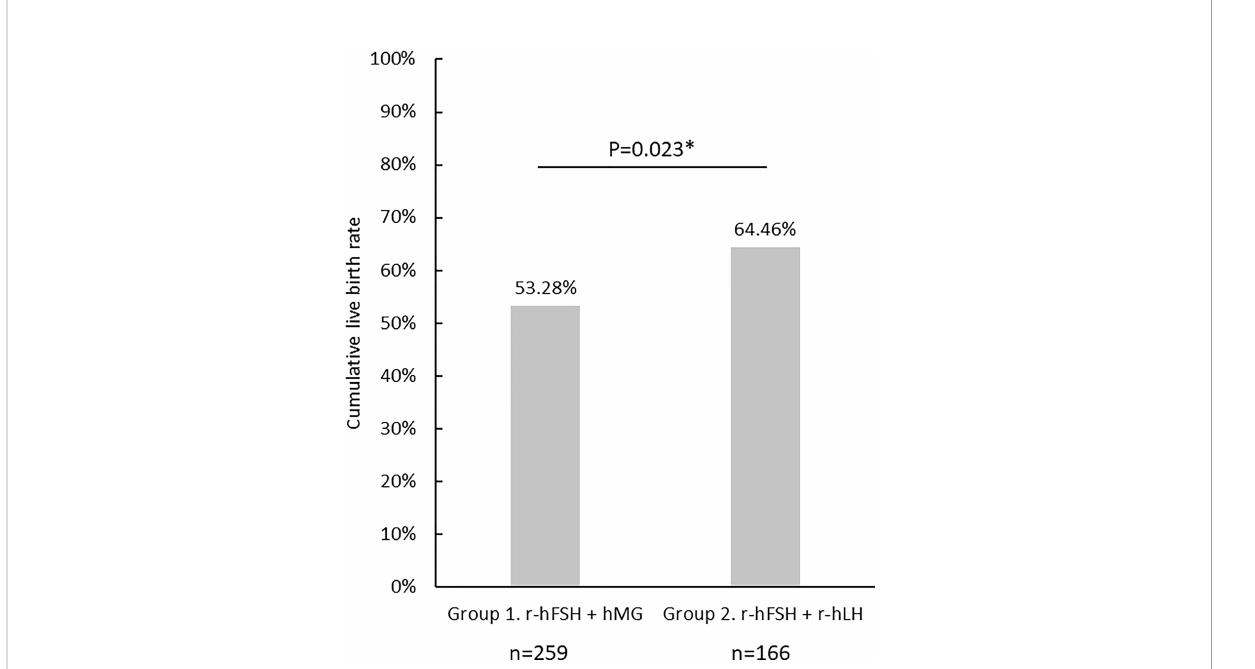
Group 1 (cLBR = 53.3%), and 107 out of 166 in Group 2 (cLBR =64.5%).